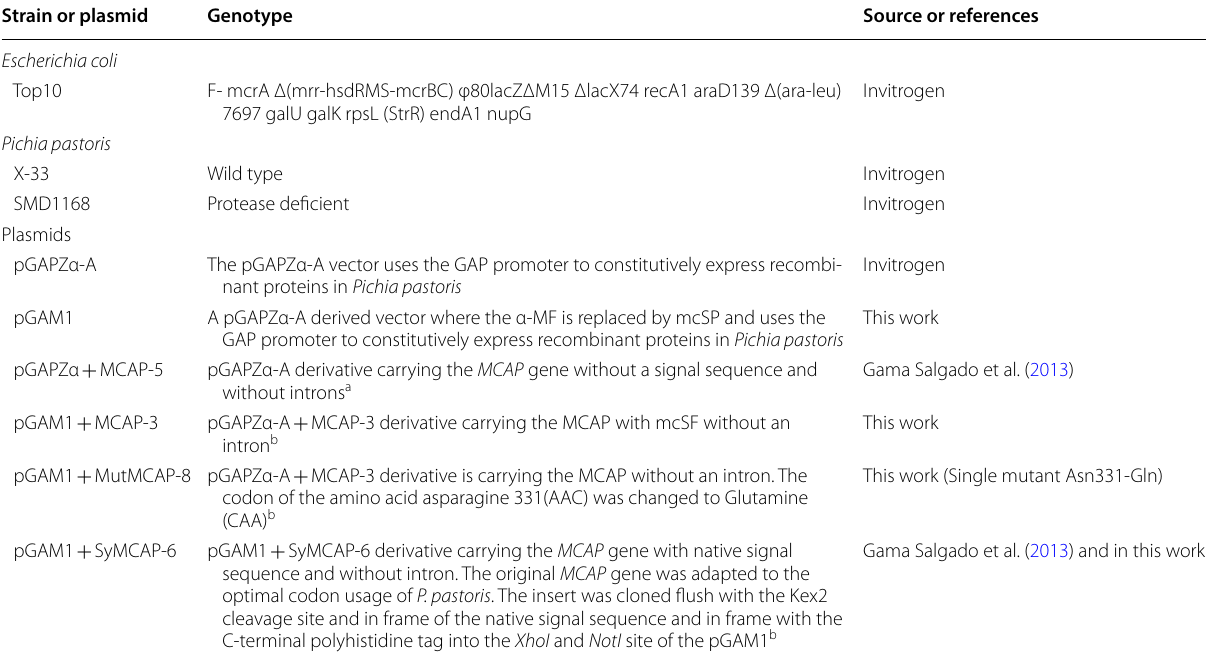
Table 1 Microorganisms and plasmids used in this